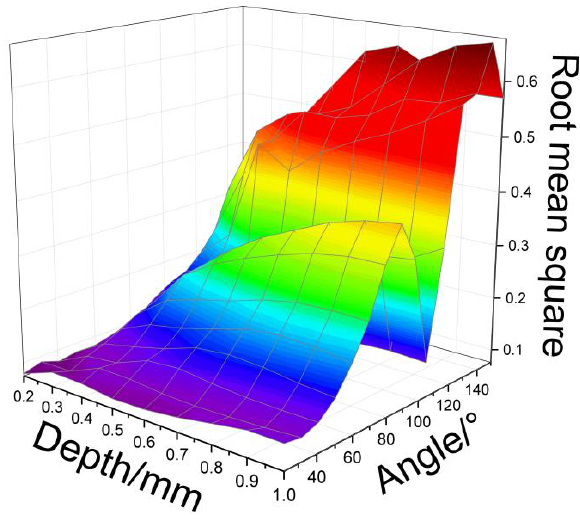
Figure 8. Three-dimensional map of the angle – depth – root mean square.